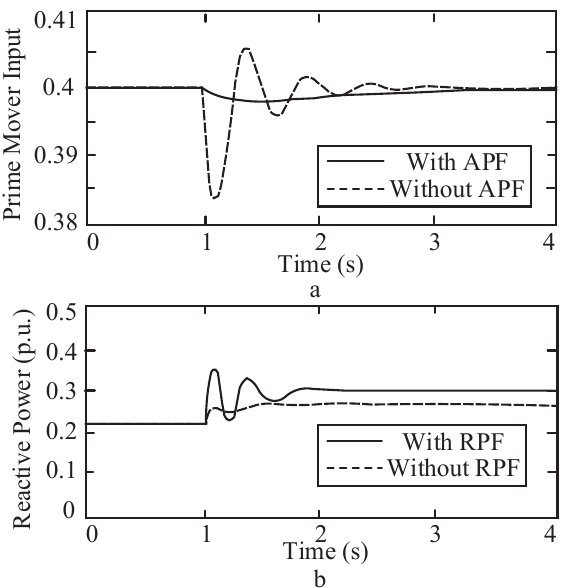
Figure 11. Ride-through capability enhancement of synchronous DG using the proposed scheme during loss of one of the parallel line ( a ) prime mover input ( b ) generator output reactive power.